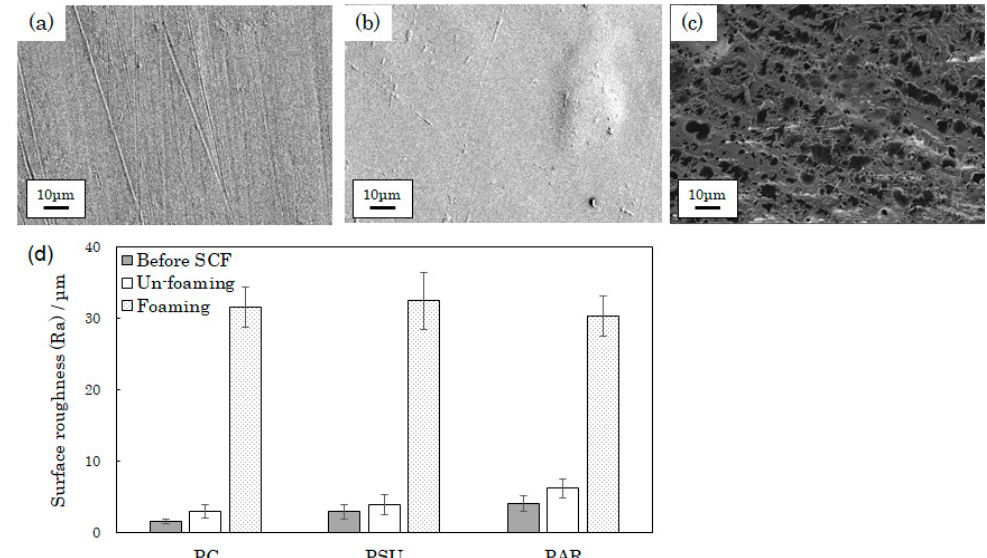
Figure 4. Surface properties of engineering plastics treated with supercritical CO 2 : SEM images of PSU ( a ) before supercritical treatment, ( b ) after supercritical treatment under nonfoaming conditions, and ( c ) after supercritical treatment with foaming. ( d ) Surface roughness ( Ra ) values of PC, PSU, and PAR before and after supercritical treatment (with and without foaming).